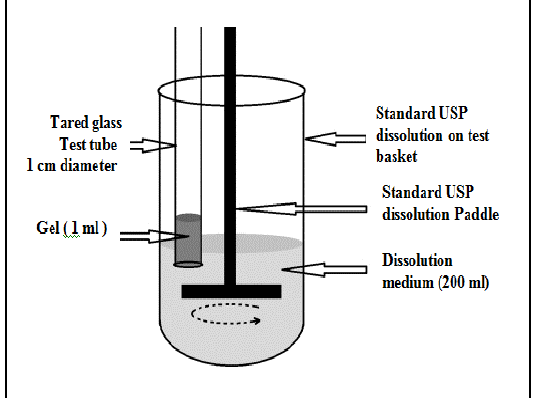
Figure (1): Modified USP XXIII in